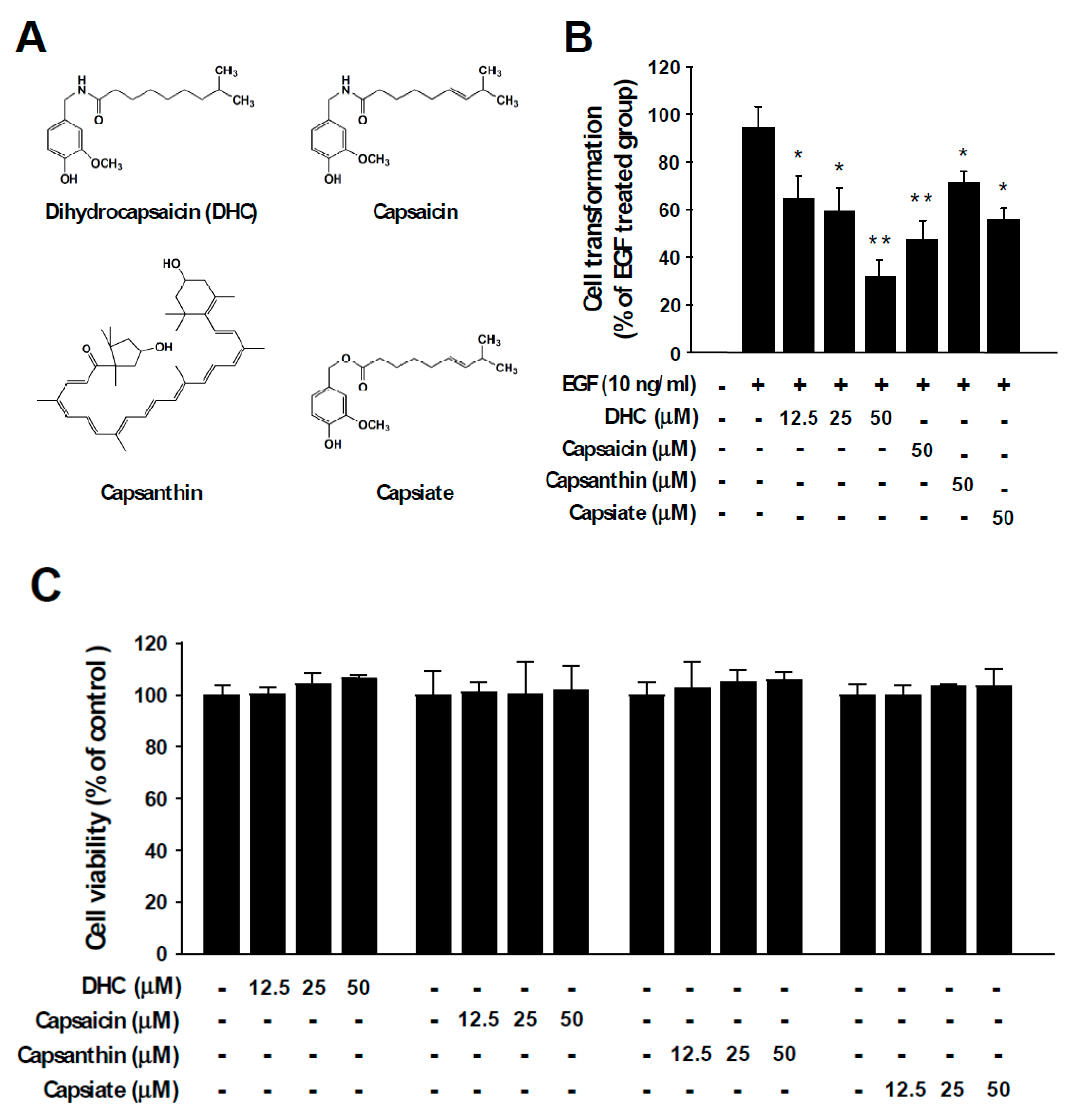
Figure 1. Chili pepper compounds inhibit epidermal growth factor (EGF)-mediated neoplastic transformation. ( A ) Chemical structures of dihydrocapsaicin (DHC), capsaicin, capsanthin, and capsiate. ( B ) EGF-induced colony formation in soft agar was used to assess anchorage-independent growth. JB6 P + cells were incubated in soft agar with the indicated compounds and EGF. Colonies were